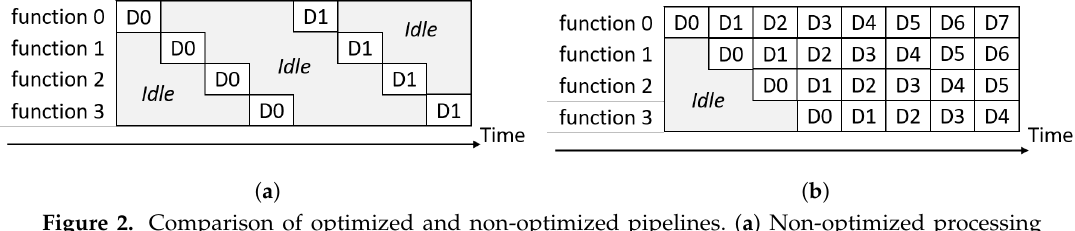
Figure 2. Comparison of optimized and non-optimized pipelines. ( a ) Non-optimized processing pipeline; ( b ) Optimized processing